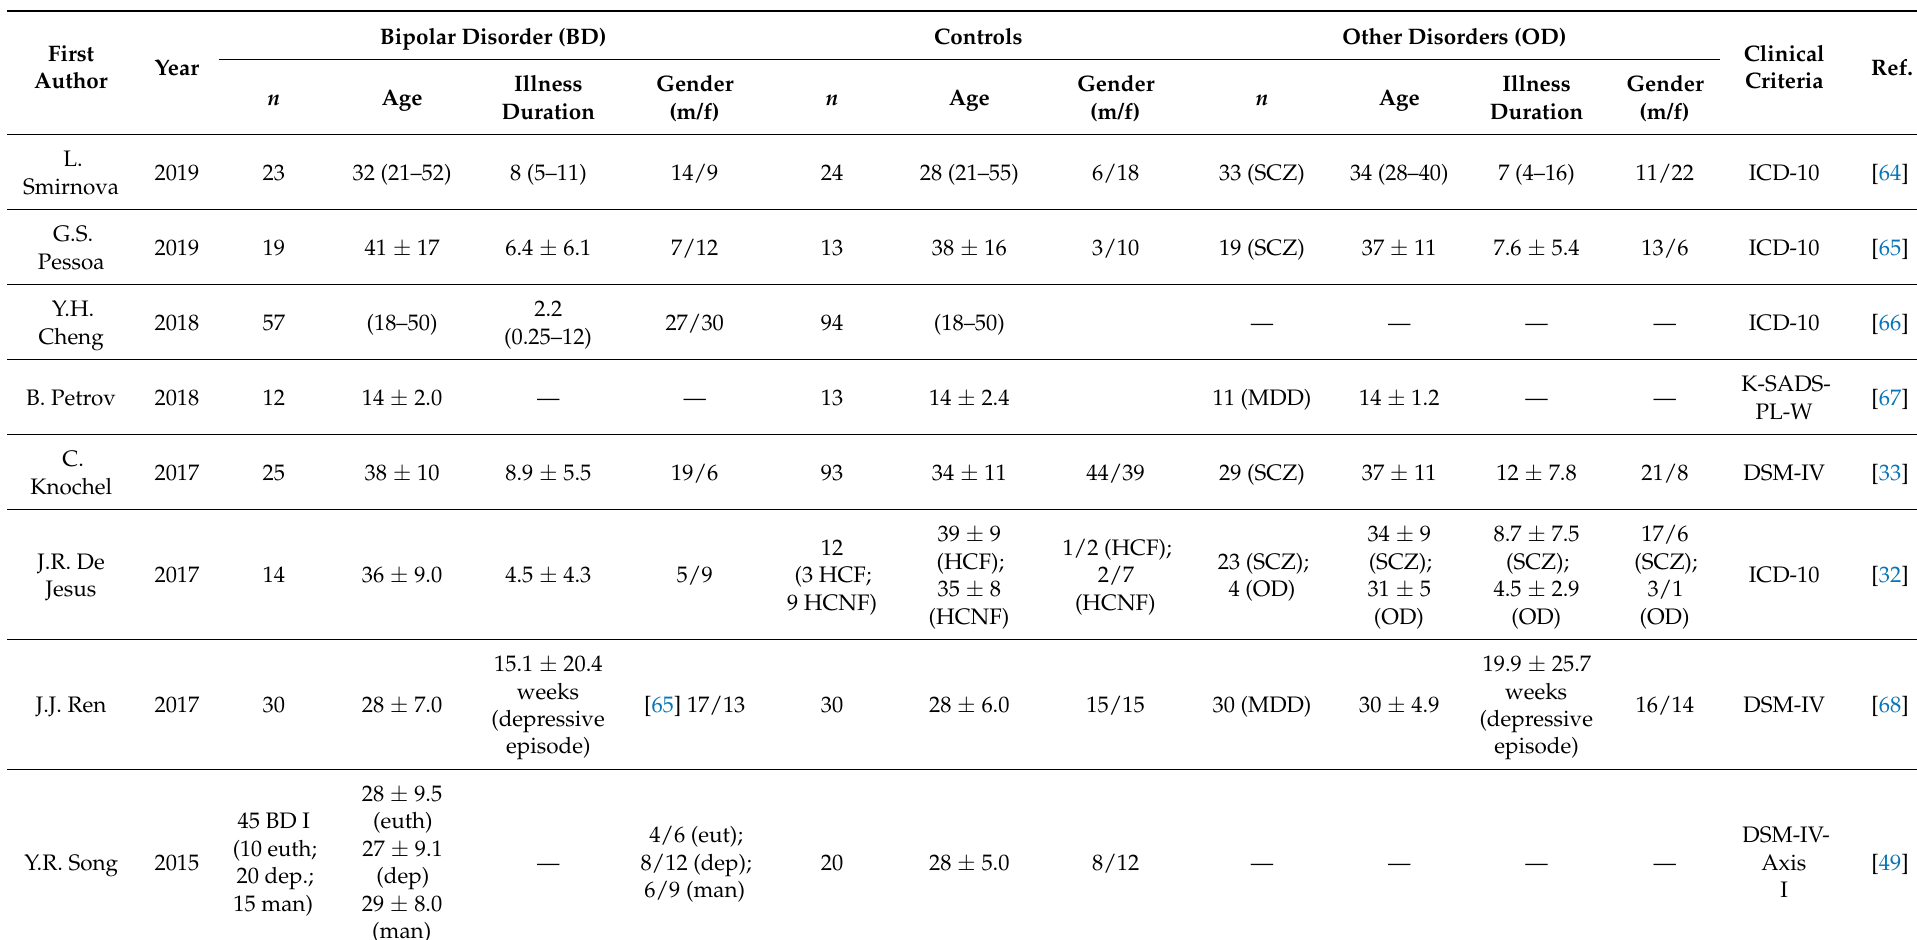
Table 1. Demographic summary of all the studies included in the systematic review of bipolar disorder and biomarkers discovery using MS-based method in human peripheral